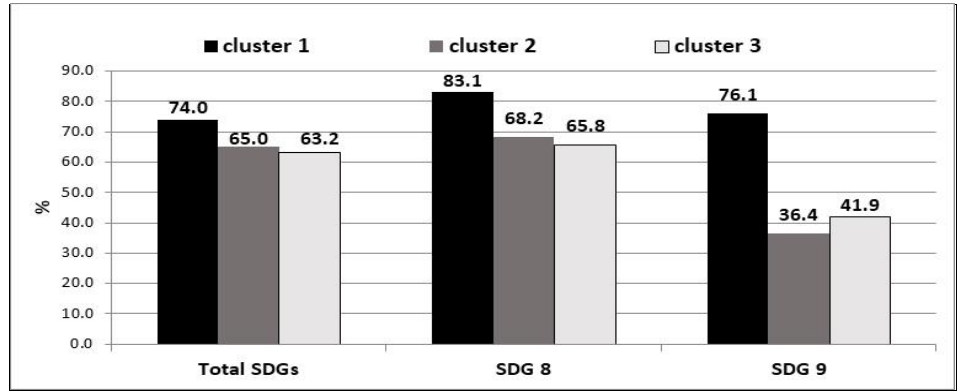
Figure 7. Sustainable Development Goals (SDGs) (mean values per cluster). Source: own calculations based on [92,93].